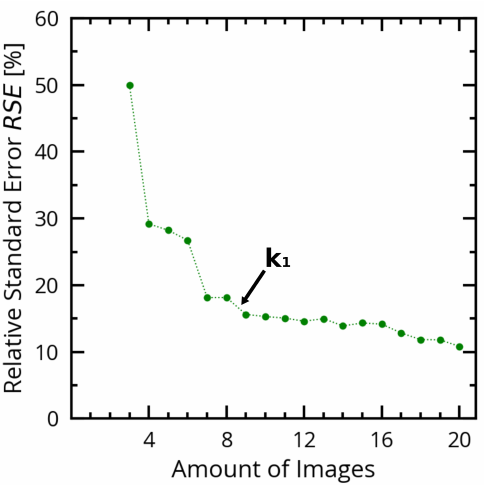
Figure 4. Relative Standard Error (RSE) of the distortion coefficient k 1 for the parameter estimation in Figure 1 with respect to the number of images in the calibration dataset (f = 25 mm). The RSE decreases with the number of image planes used for the parameter estimation. In our dataset the error k 1 becomes reliable with seven or more images for calibration as the RSE falls below